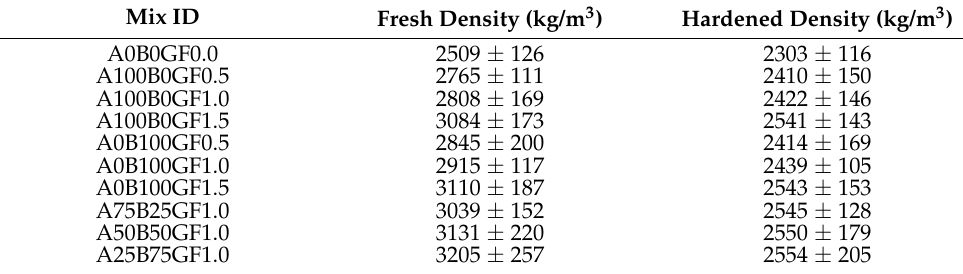
Table 6. Fresh and hardened densities of geopolymer concrete